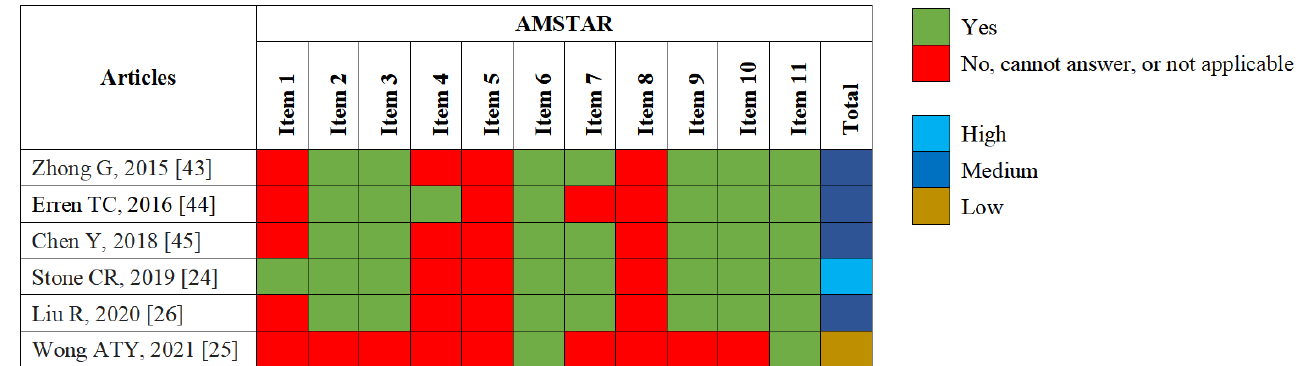
Figure 2. Methodological quality appraisal of each eligible systematic review or meta-analysis with